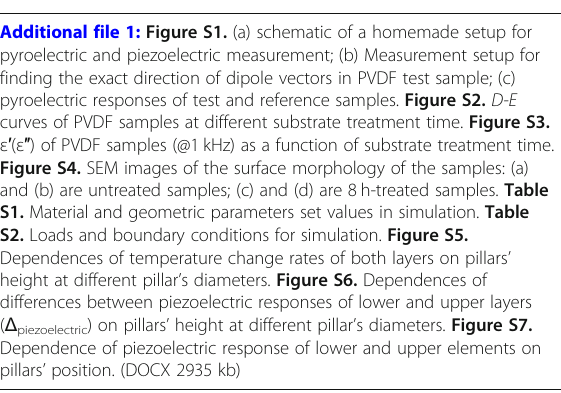
Additional file